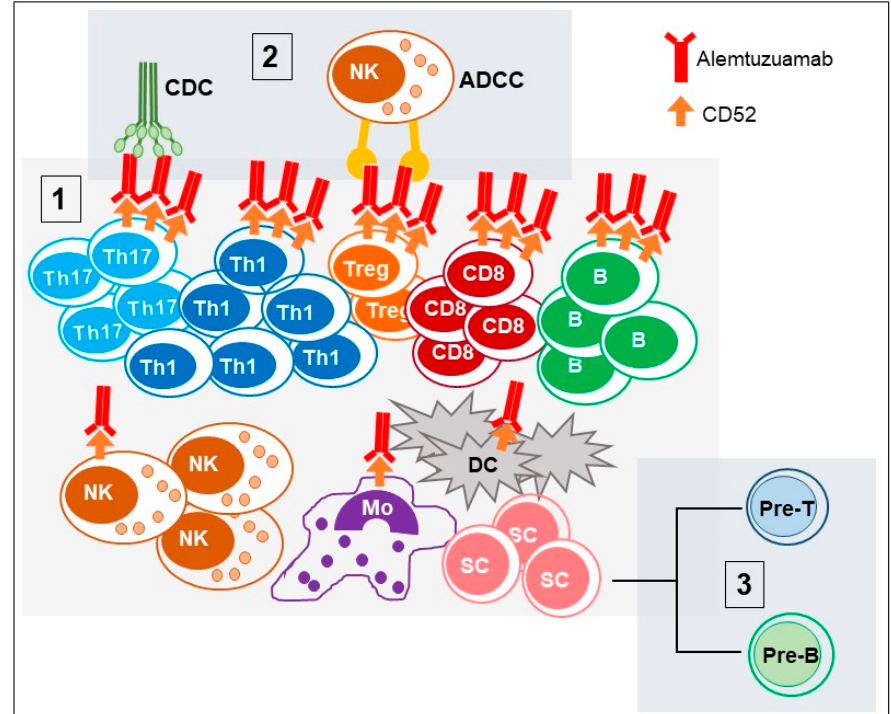
Figure 1. Alemtuzumab mechanism of action. Alemtuzumab exerts its function through three main phases: 1. Selection: Alemtuzumab selectively binds to CD52 antigen that is highly expressed on T